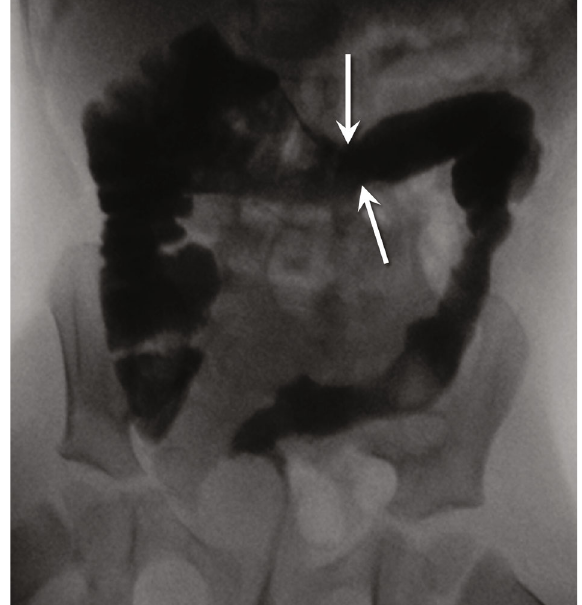
Figure 2: Frontal image from retrograde water-soluble contrast enema demonstrates narrowing of the left colon, with loss of the typical haustral markings. A transition point is identi fi ed in the mid-distal transverse colon (arrows). The right colon is normal.